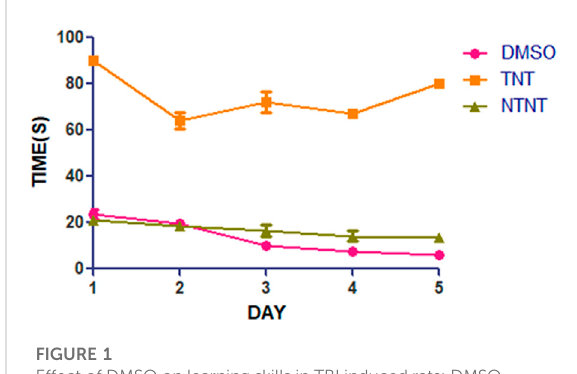
FIGURE 1 Effect of DMSO on learning skills in TBI induced rats; DMSO-